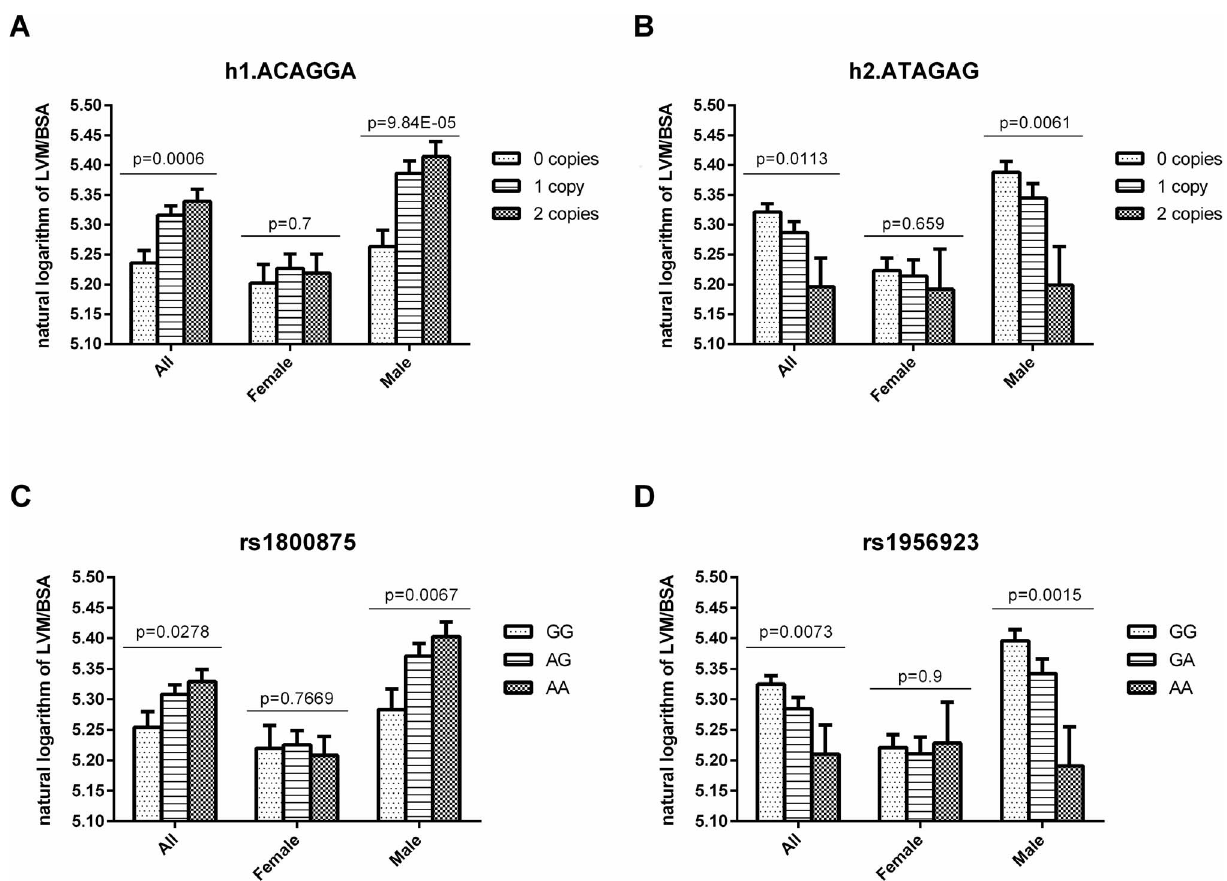
Figure 2. CMA1 polymorphisms and heart mass in patient with aortic stenosis. Association between haplotypes h1.ACAGGA (A) and h2.ATAGAG (B) in the CMA1 gene and potentially functional polymorphisms rs1800875 (C) and rs1956923 (D) in the promoter region of CMA1 gene and natural logarithm of LVM/BSA in patients with aortic stenosis. Values are means with the SEM indicated by error bars. patients (Table 3 and Figure 2): h1.ACAGGA (mean: 193.1 for zero copies, 218.3 for one copy, 224.5 for two copies, p = 9.84 6 10 2 5 and p =0.00075 for the crude and full models, respectively), h2.ATAGAG (mean: 218.8 for zero copies, 209.6 for one copy, 181.1 for two copies, p = 0.0061 and p = 0.0168 for the crude and full models, respectively). In contrast, no significant LVM/BSA differences were found in women (Table 3).